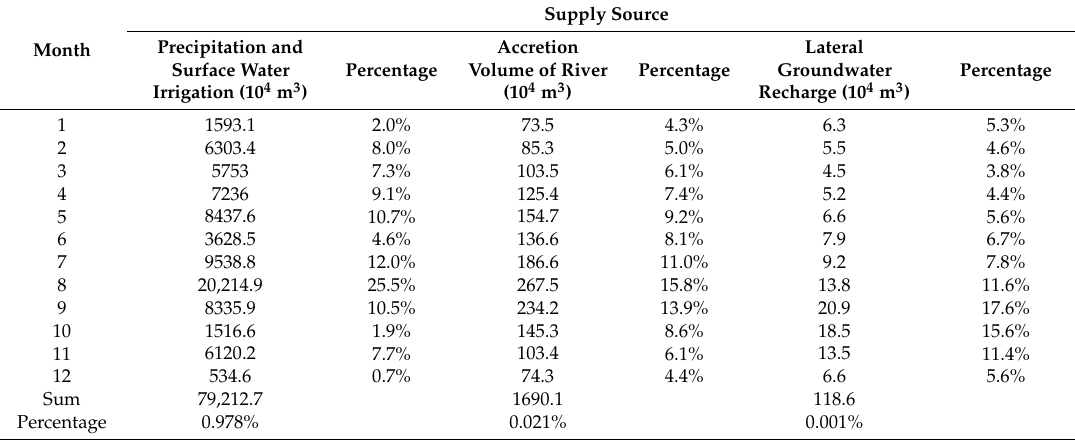
Table 4. Simulation results of groundwater recharge in